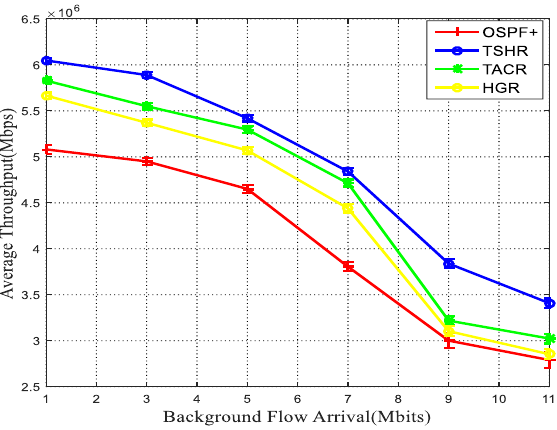
Figure 12. Throughput vs. background flow